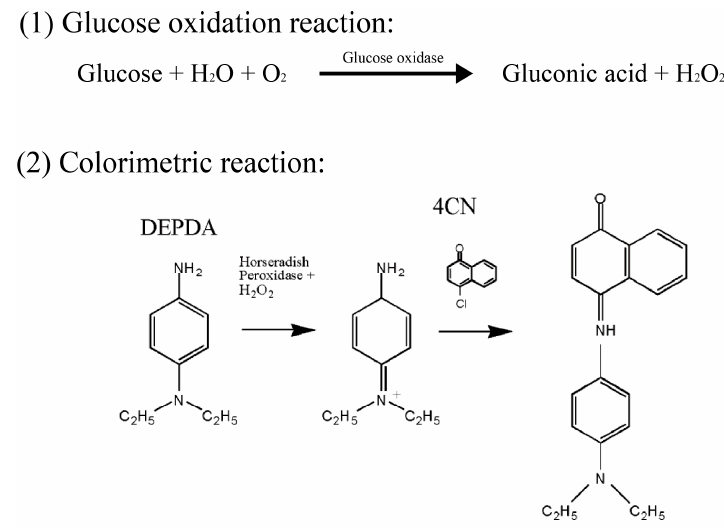
Figure 1. Glucose oxidation and colorimetric reaction utilized in this paper.